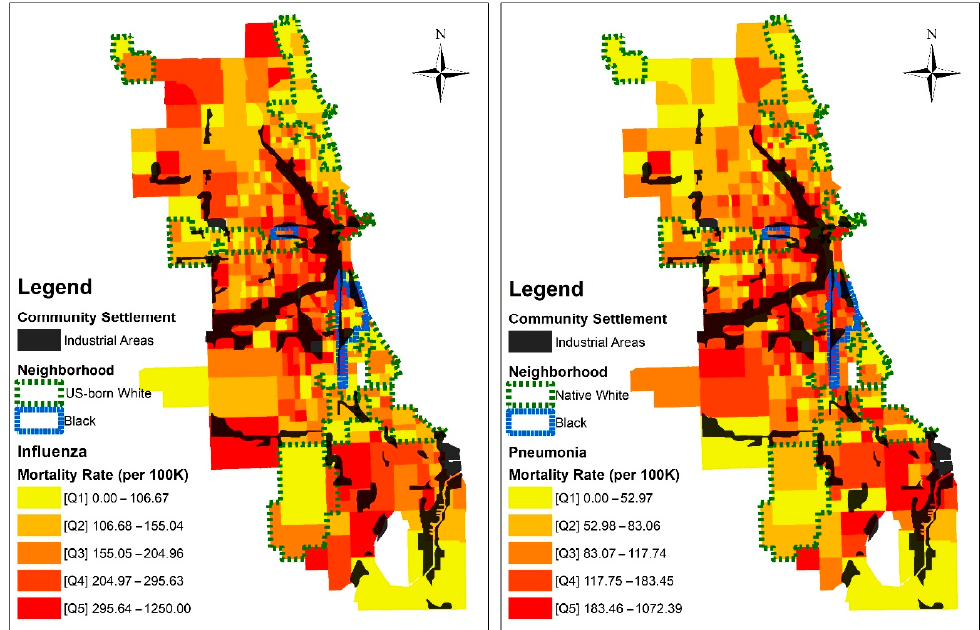
Figure 2. Map of the 1918 influenza and pneumonia mortality rates and census tract characteristics. Table 1 provides statistics for influenza and pneumonia mortality during the 1918 pandemic. The highest mortality rates occur near industrial areas where many Black (influenza rate = 238.5 per 100,000, pneumonia rate = 168.1 per 100,000) and non-US-born White (influenza rate = 247.1 per 100,000, pneumonia rate = 155.5 per 100,000) residents lived. US-born White residents, who lived in non-industrial areas, had the lowest mortality Table 1. The estimated number of Chicago influenza and pneumonia deaths in 1918 by majority race and residential proximity to industrial areas.